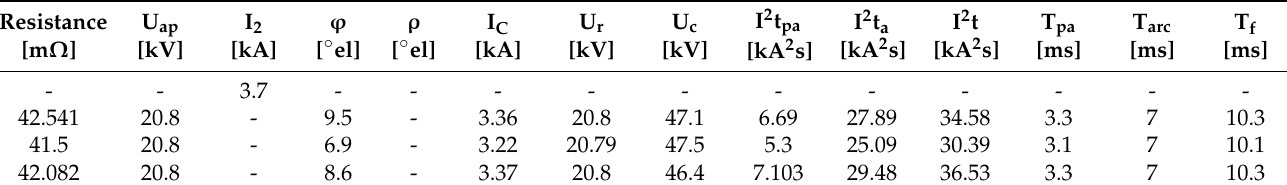
Figure 14. ( a ) Oscillogram obtained for the making angle of short-circuit current of 8.6 electrical degrees; ( b ) connection detail in the oscillogram. Table 8. Values obtained in I 2 series of tests.